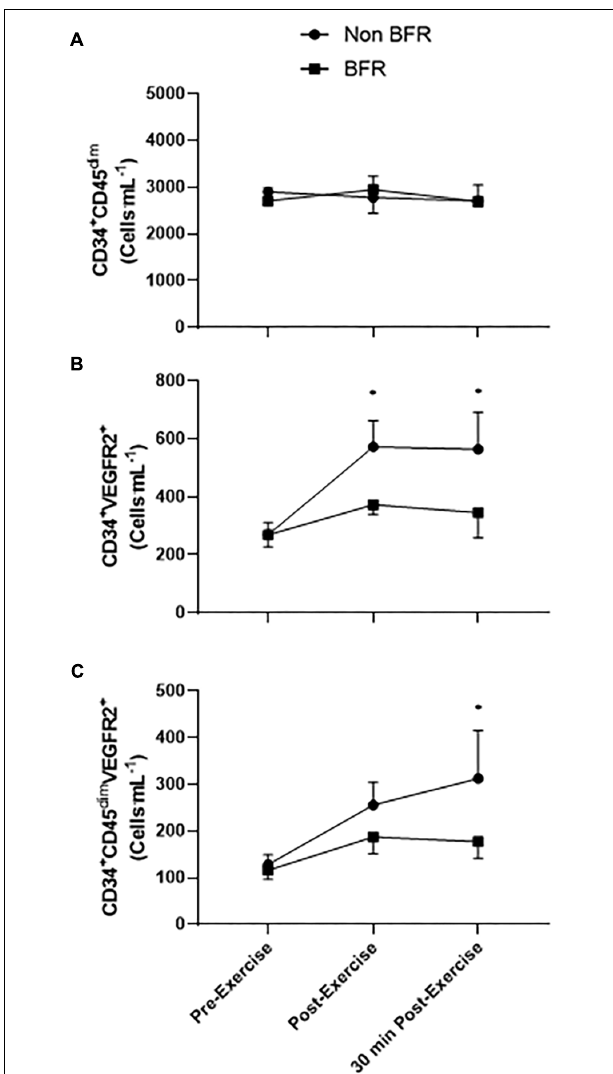
FIGURE 2 | Circulating CD34 + CD45 dim , CD34 + VEGFR2 + EPCs, and CD34 + CD45 dim VEGFR2 + EPCs in response to blood flow restricted (BFR) and non-restricted (non-BFR) exercise ( n = 9). Values shown are mean ± SEM, ∗ p < 0.05 vs. pre-exercise non-BFR